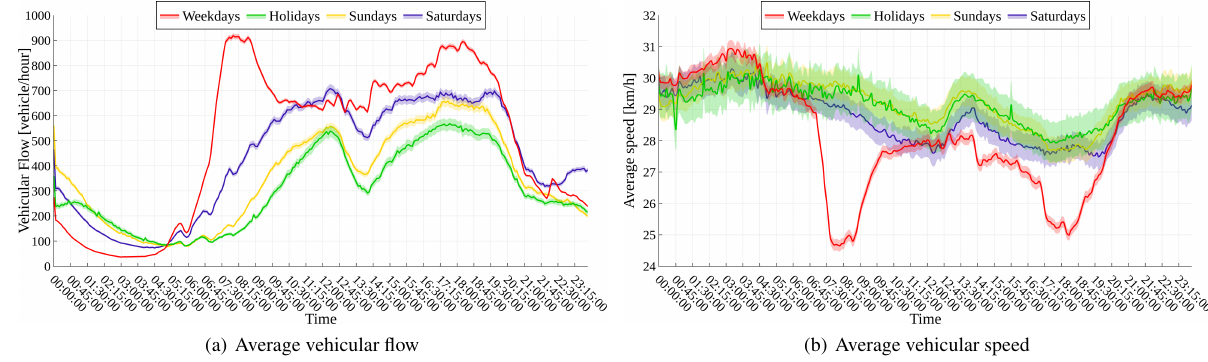
Figure 2. Vehicular flows in the city of Turin categorized by type of day (bands represent 95% confidence interval)